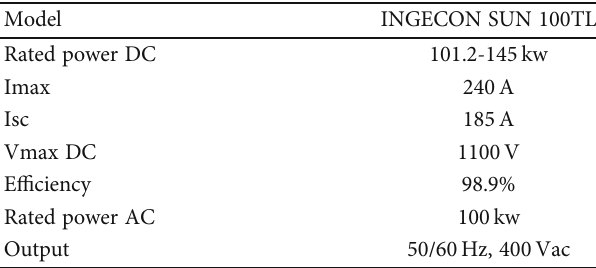
Figure 4: Grid connected PV system model. Table 4: Inverter speci fi